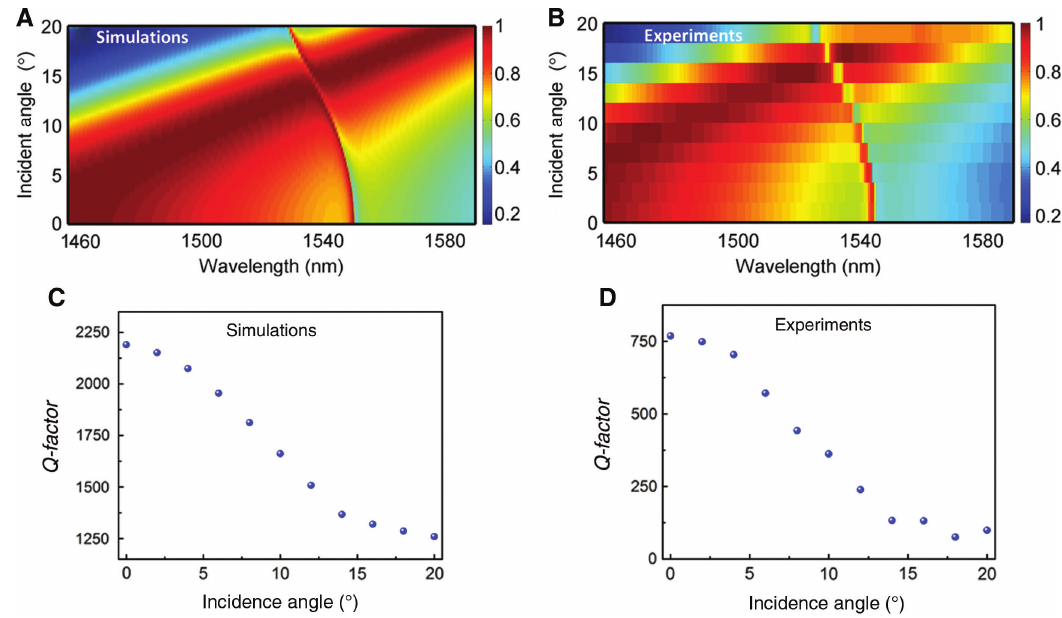
Figure 4: Angular response of the quasi-BIC structure. (A) Numerical simulations of the reflectivity for different incidence angles using CST from 0 ° to 20 ° . (B) Measured reflectivity for different incidence angles from 0 ° to 20 ° . (D) Extracted quality factor from the experimental results as a function of the incidence angle. (C) Quality factor obtained by rational fitting as a function of the incidence angle, evidencing that the sensor has higher Q factor at normal incidence. (C) and (D) show good agreement between experiment and numerical simulations. The discrepancy between the quality factor from simulations (2 × 10 3 at normal incidence) and that from the experiment (750 at normal incidence) is due to the finite size and fabrication imperfections (mostly the roughness of the silicon substrate).